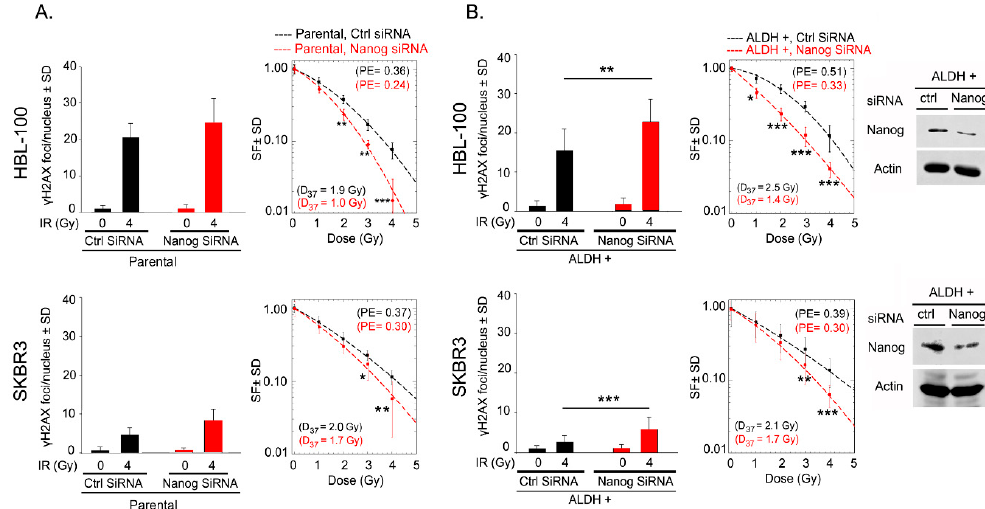
Figure 2. Nanog expression is correlated with ALDH activity and radioresistance. ( A ) Nanog expression was modulated via siRNA and plasmid-based overexpression in the indicated cells as described in the methods. Protein samples were isolated 48 h after cell transfection, and the transfection efficiency was analyzed by Western blotting. ( B ) ALDH activity was measured via an Aldefluor assay using flow cytometry 48 h after transfection. Bars represent the mean relative ALDH activity ± the standard deviation (SD) from three independent experiments ( n = 6; * p < 0.05, and ** p < 0.01, Student’s t-test). ( C ) Forty-eight hours after transfection with Nanog siRNA or Nanog expression plasmid, cells were plated for colony formation, irradiated 24 h later and incubated for 10-14 days. Data points represent the mean surviving fraction (SF) ± the standard deviation (SD) from two independent experiments ( n = 12; * p < 0.05, ** p < 0.01, and *** p < 0.001, Student’s t-test; ctrl: control, PE = plating efficiency).